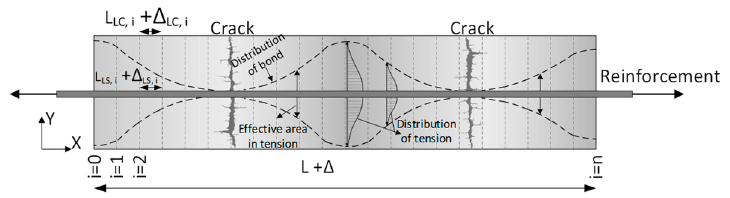
Figure 3. Conceptual fi gure of the e ff ective area in tension.